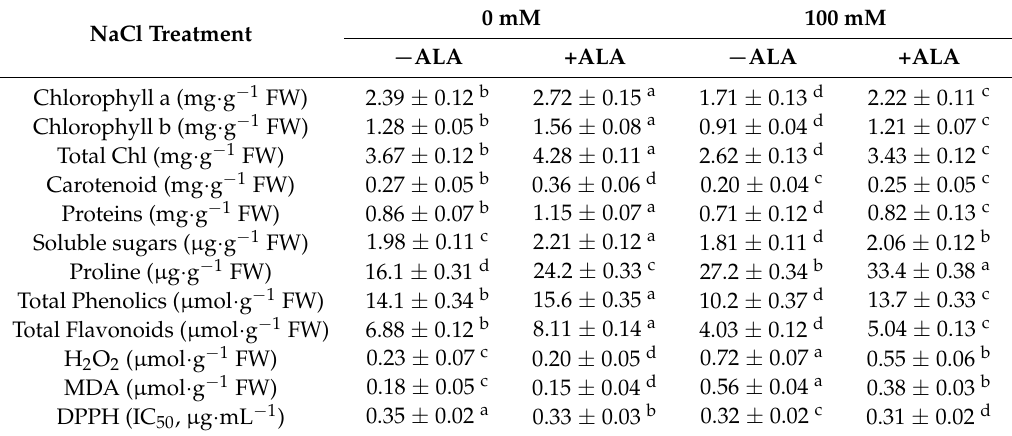
Table 9. Contents of chlorophyll, carotenoids, proteins, sugars, proline, phenolics, flavonoids, H 2 O 2 , MDA and antioxidant activity (DPPH) in leaves of Cambrinus cultivar under salt and/or ALA (7 ppm)